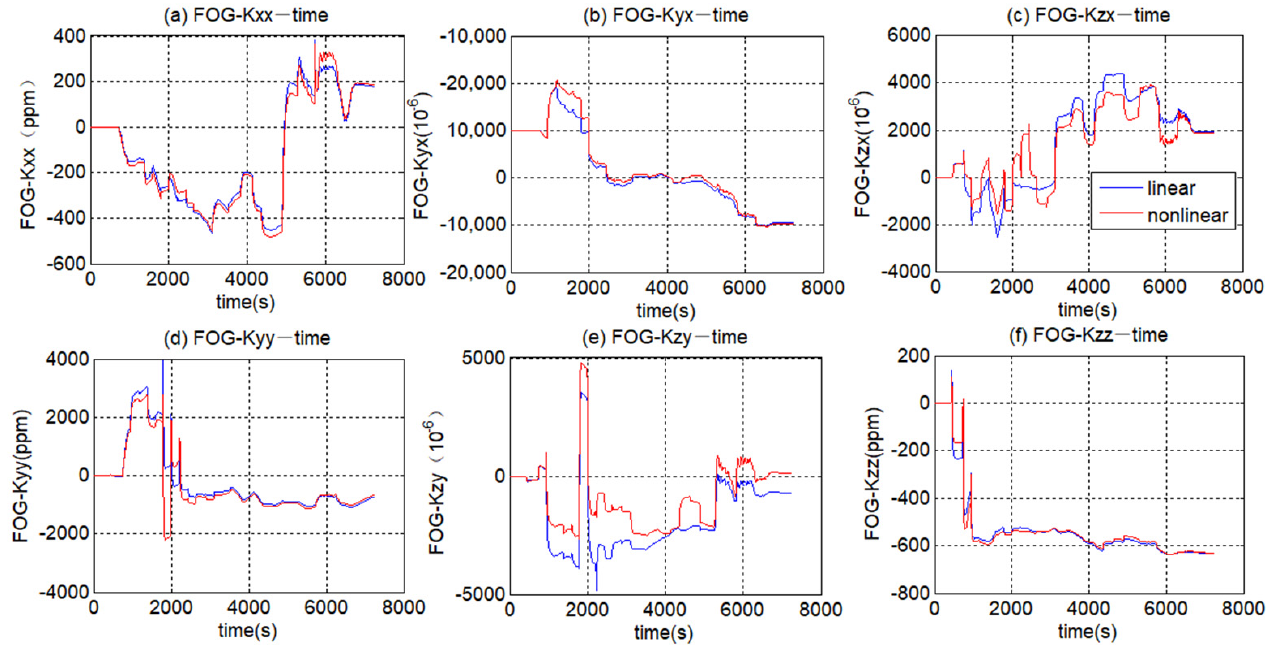
Figure A3. Estimated results of the scale factor error and misalignment error